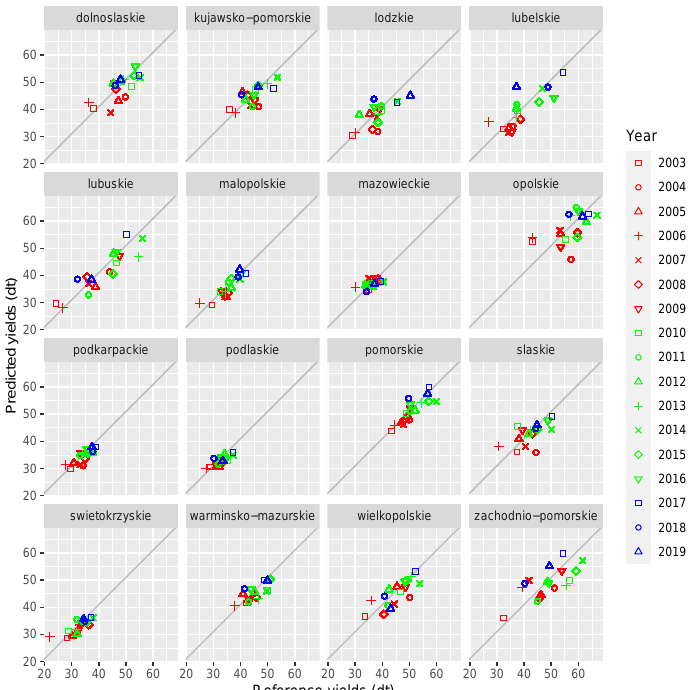
Figure 9. Comparison of crop yield predictions with the reference statistics for winter wheat at NUTS-2 level. The RMSE and bias of this relationship is given in Figure 7.